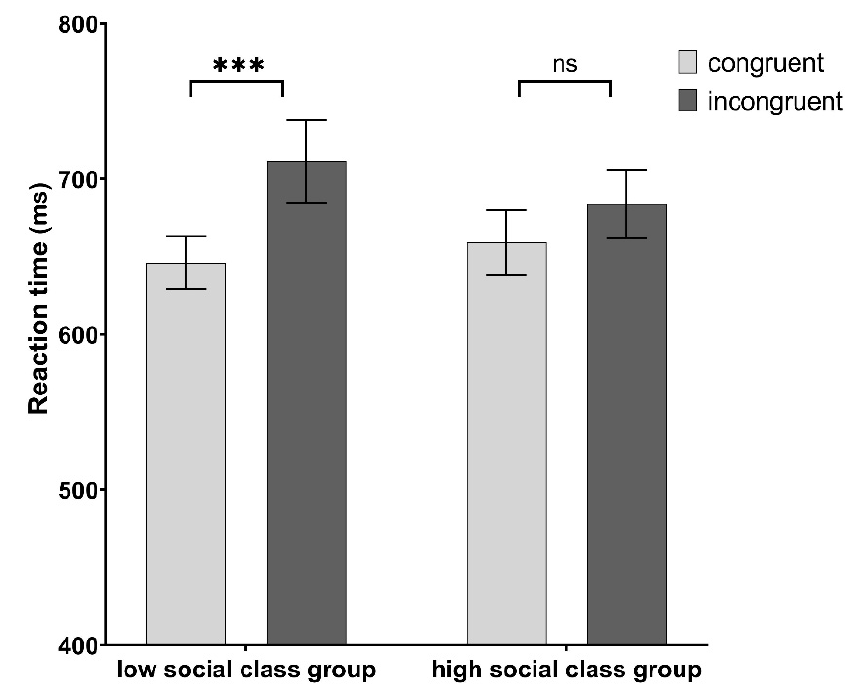
Figure 3. Mean (and standard error) of reaction time of different groups in congruent task and incongruent task (*** p < 0.001).